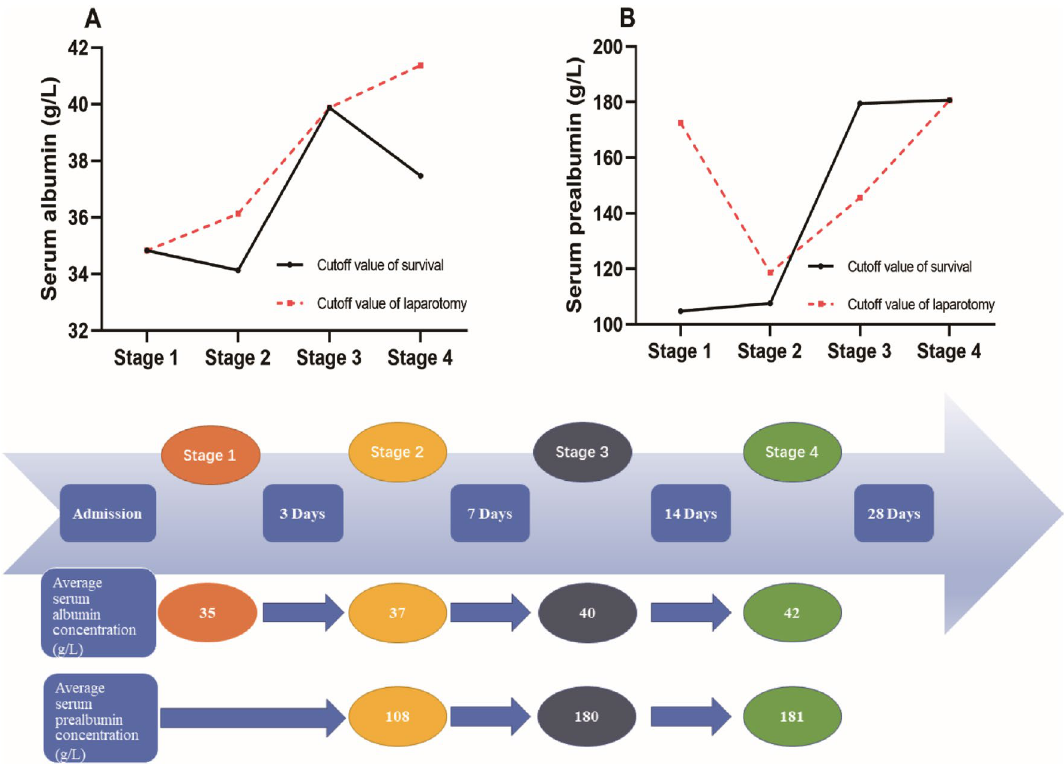
Figure 6. Summary of the albumin and prealbumin cut-off values at different stages of SAP. The upper figure shows the cut-off value tendency of serum albumin/prealbumin. The higher values of each stage are listed in the lower figure as the goal to be reached during clinical